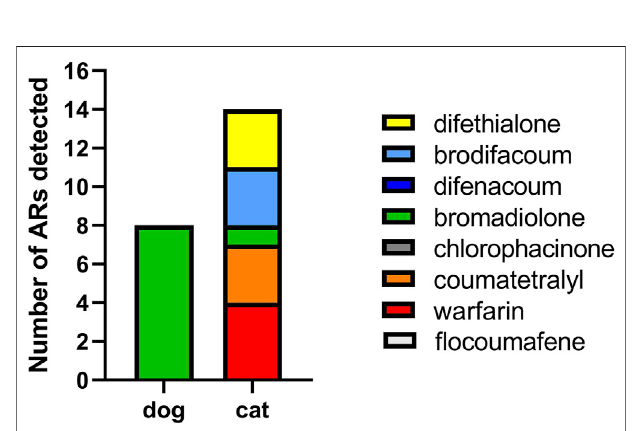
FIGURE 3 | Exposure to AR of cats and dogs. Occurrence of each AR compound in the exposed dogs ( n = 8) and cats ( n = 13) with one cat dually exposed to brodifacoum and